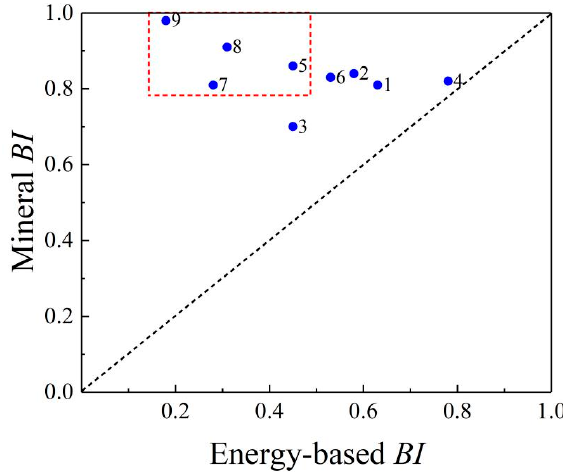
Figure 9. Comparison between the energy-based BI and the mineral BI .